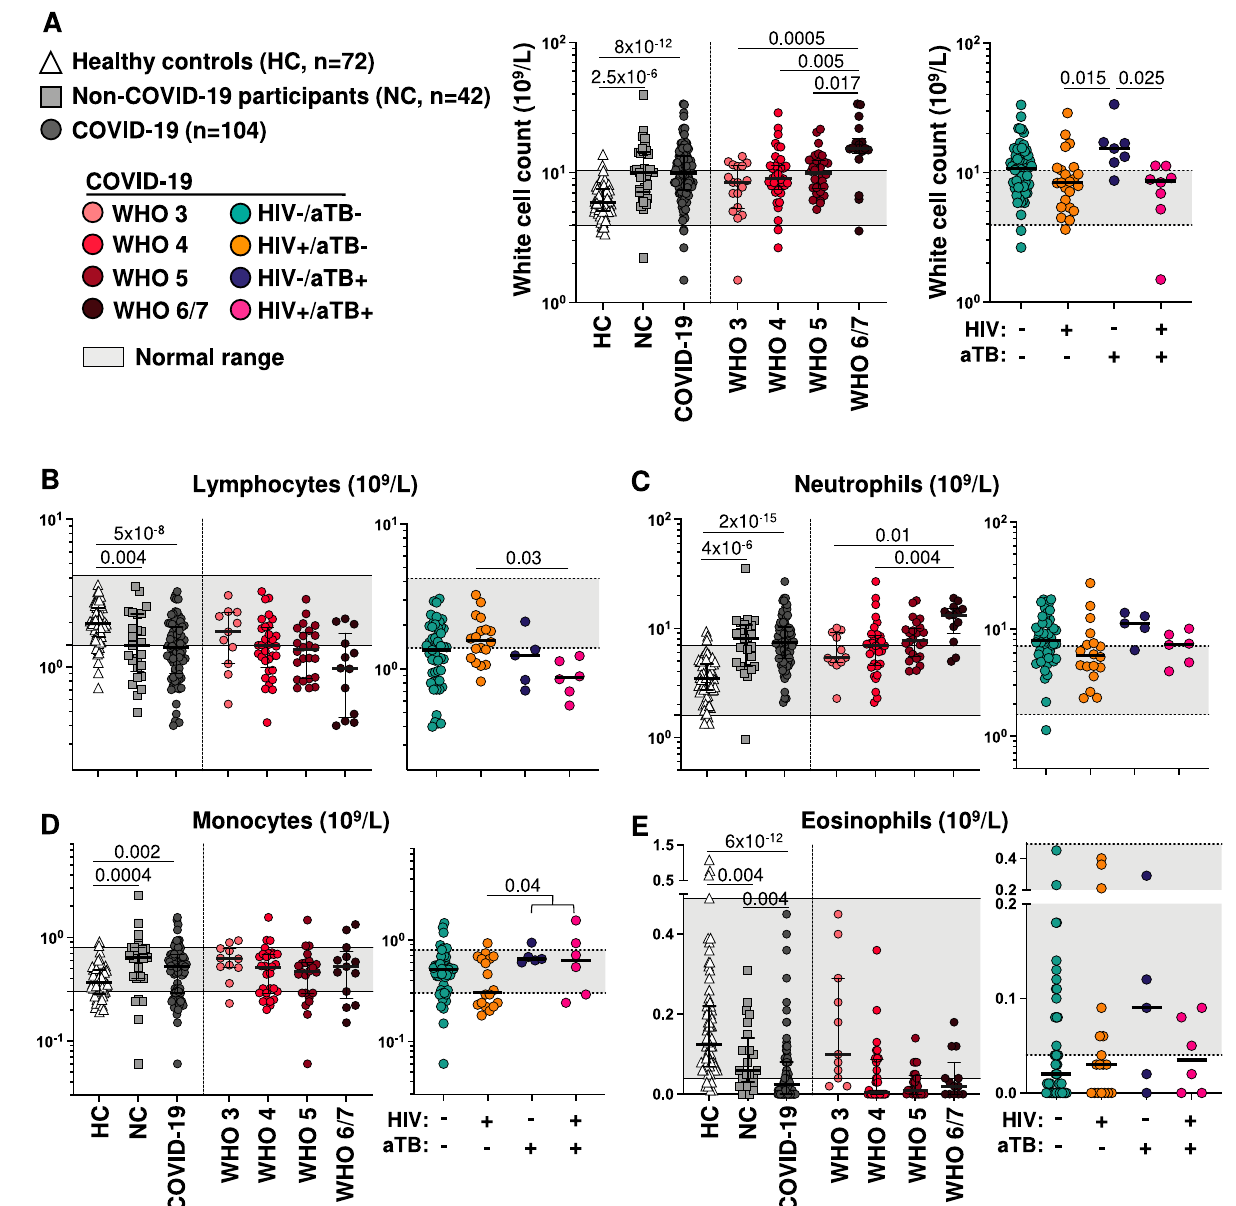
Fig. 2 | Total white cell and differential count in healthy persons (HC), non- COVID-19 hospitalized participants (NC), and COVID-19 participants. A The total white cell count was raised in both COVID-19 and NC patients with no dif- ferences between the groups. The count increased with increasing COVID-19 severity.AmongstCOVID-19patientsthe totalwhitecellcountwas highest inHIV-1 uninfected patients with coincident tuberculosis. B The lymphocyte count was lowerinbothCOVID-19andNCpatientswithnodifferencesbetweenthesegroups. The count tendedto decreasewith increasing COVID-19severity.Amongst COVID- 19 patients the lymphocyte count was lowest in triply infected patients with HIV-1 and coincident tuberculosis. C The neutrophil count was raised in both NC and COVID-19 patients with no differences between the groups. The count increased with increasing COVID-19 severity. Amongst COVID-19 patients there were no